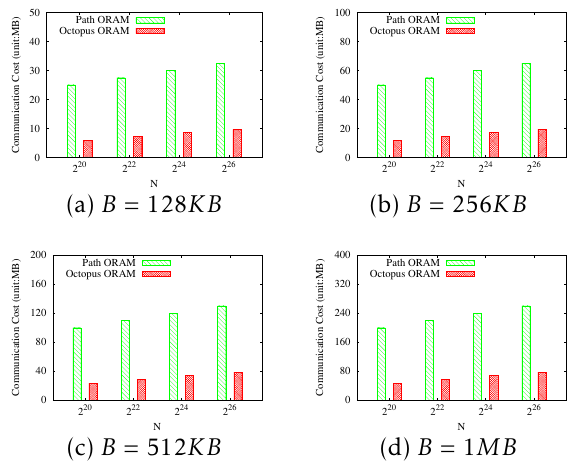
Figure 7. Comparing Communication Cost per Query Between Octopus ORAM and Path ORAM.